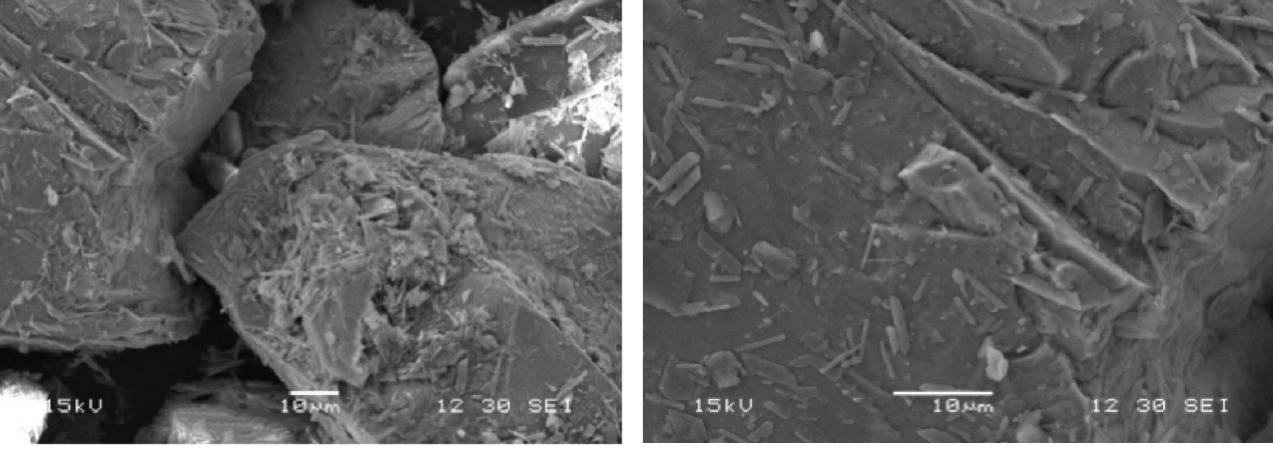
Figure 6. Fine particle scan results.